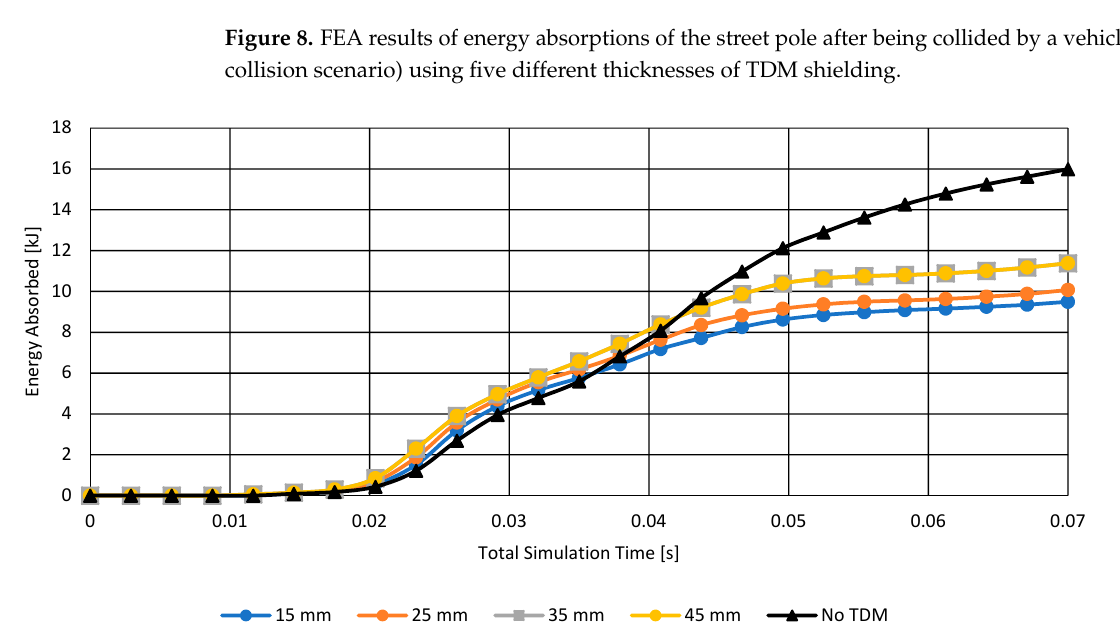
Figure 9. FEA results of energy absorptions of the vehicle after colliding on a street pole (corner collision scenario) using five different thicknesses of TDM shielding.